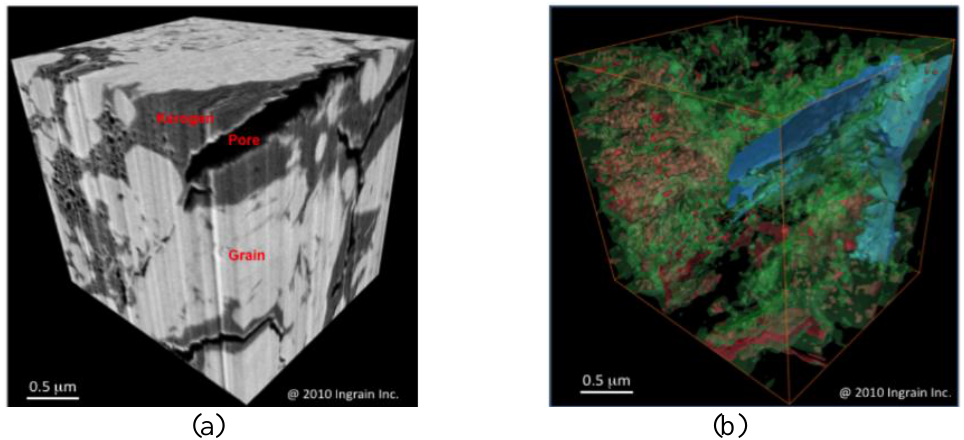
Figure 2—(a) Rendered volume of shale at the highest nano-resolution. (b) Kerogen (green), disconnected pores (red) and connected porosity (blue). The scale is 500 nanometres.